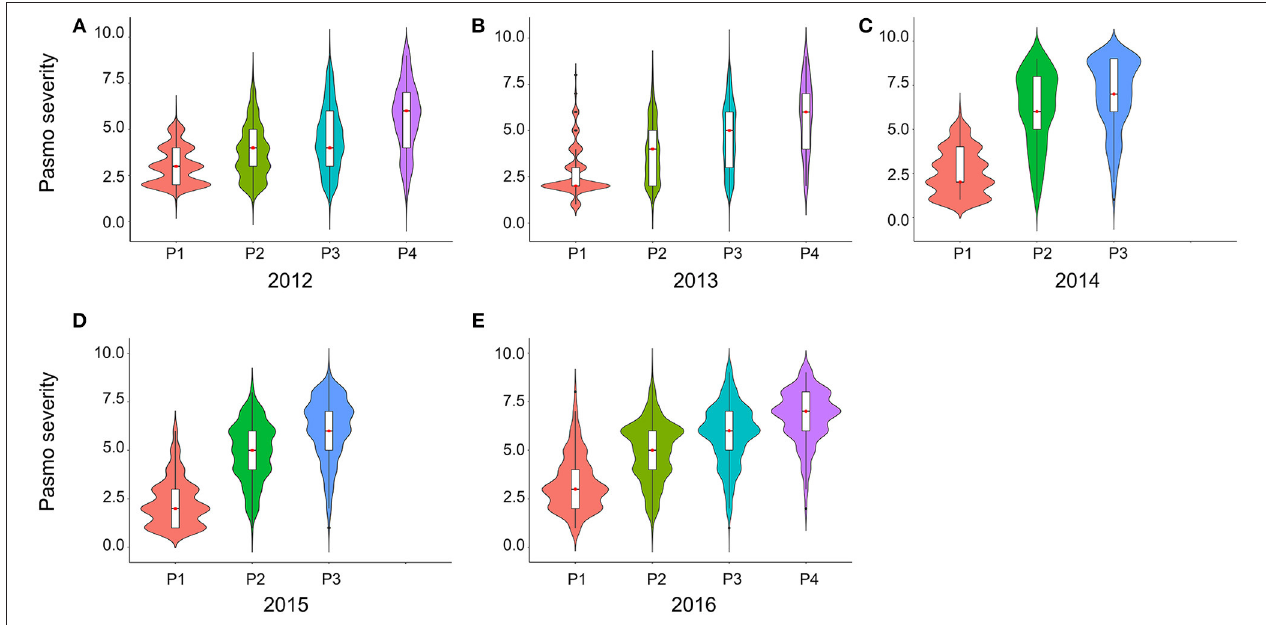
FIGURE 2 | Violin plots of pasmo severity observed in various growth stages in 2012 (A) , 2013 (B) , 2014 (C) , 2015 (D) , and 2016 (E) .